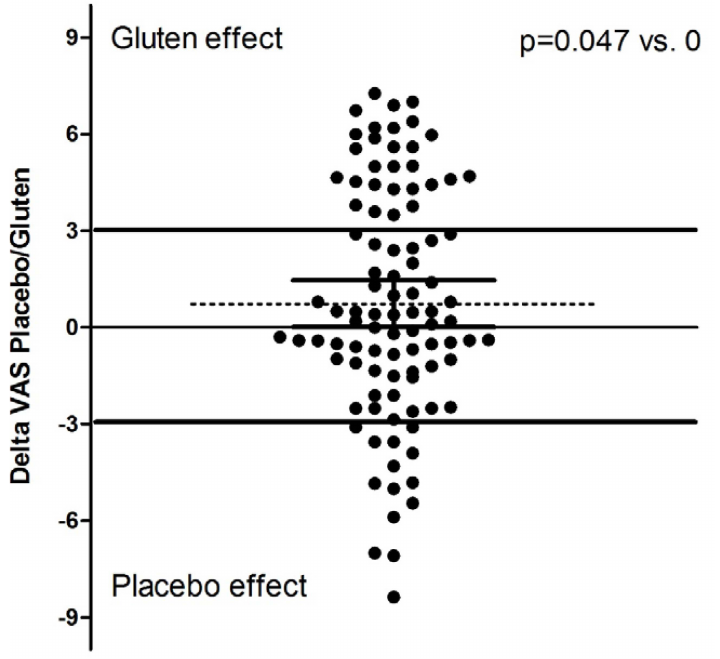
Figure 2. Distribution of the differences between the global well-being visual analogue scale (VAS) after the gluten vs. placebo challenge. The dotted line shows the mean ( p = 0.047 vs. 0). 95% CI are reported (0.01–1.5). The continuous lines show the identity line (=0), the cut-off of the difference (3) chosen to define patients with NCGS and the line identifying patients of the placebo responsive group ( ď´